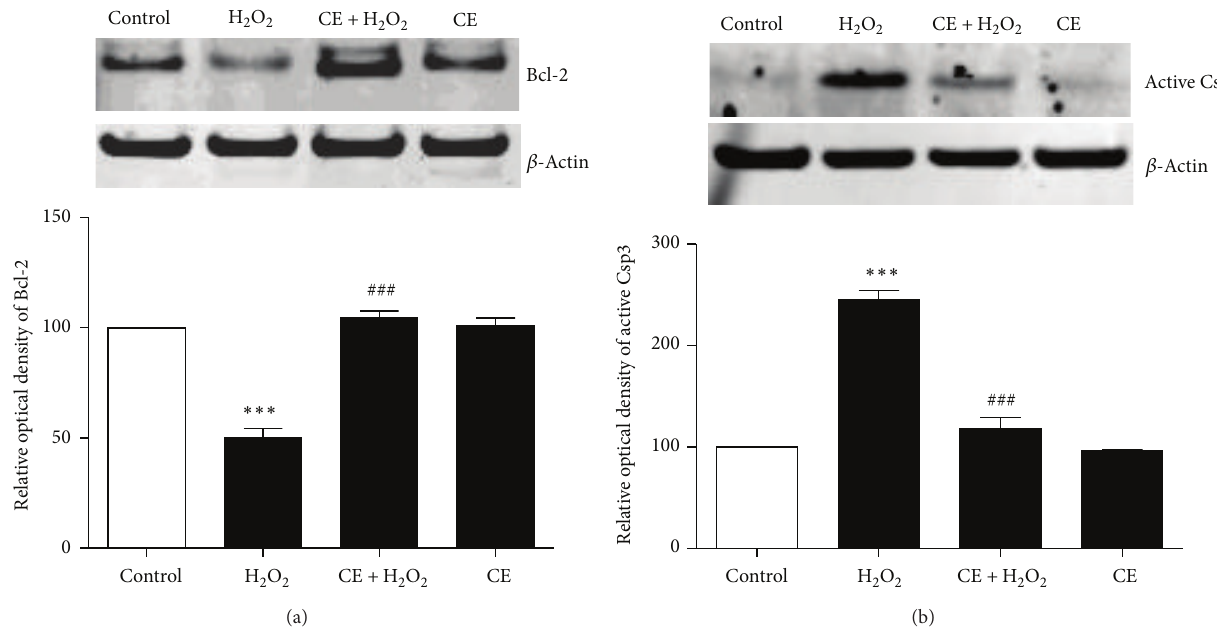
Figure 4: Neuroprotection by CE involves Bcl-2 and Csp3. (a) Representative western blot probed with an antibody specific against Bcl-2 after various treatments in the neurons. 𝛽 -Actin served as an internal control. Summary of the optical density of Bcl-2. Results showed that CE significantly inhibited H 2 O 2 induced decreases in the content of Bcl-2. (b) Representative western blot probed with an antibody specific against active Csp3 after Csp3 various treatments in the neurons. Actin served as an internal control. Summary of the optical density of active Csp3. Results showed that H 2 O 2 -induced activation of Csp3 was blocked by CE. ∗ refers to a comparison of the control group; # refers to a comparison of the H 2 O 2